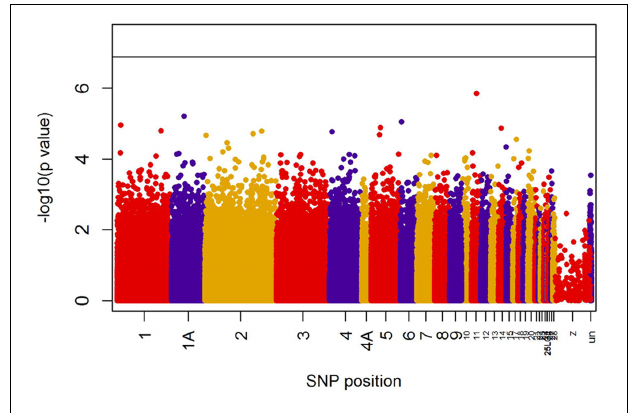
FIGURE 1 | Significances (shown as –log10) of all SNPs included in the genome-wide association analyses of egg-laying date assuming temperature-independent SNP effects. The black line indicates the genome-wide significance level equivalent to P = 0.05 after applying a Bonferroni correction. Points are color-coded by chromosome.